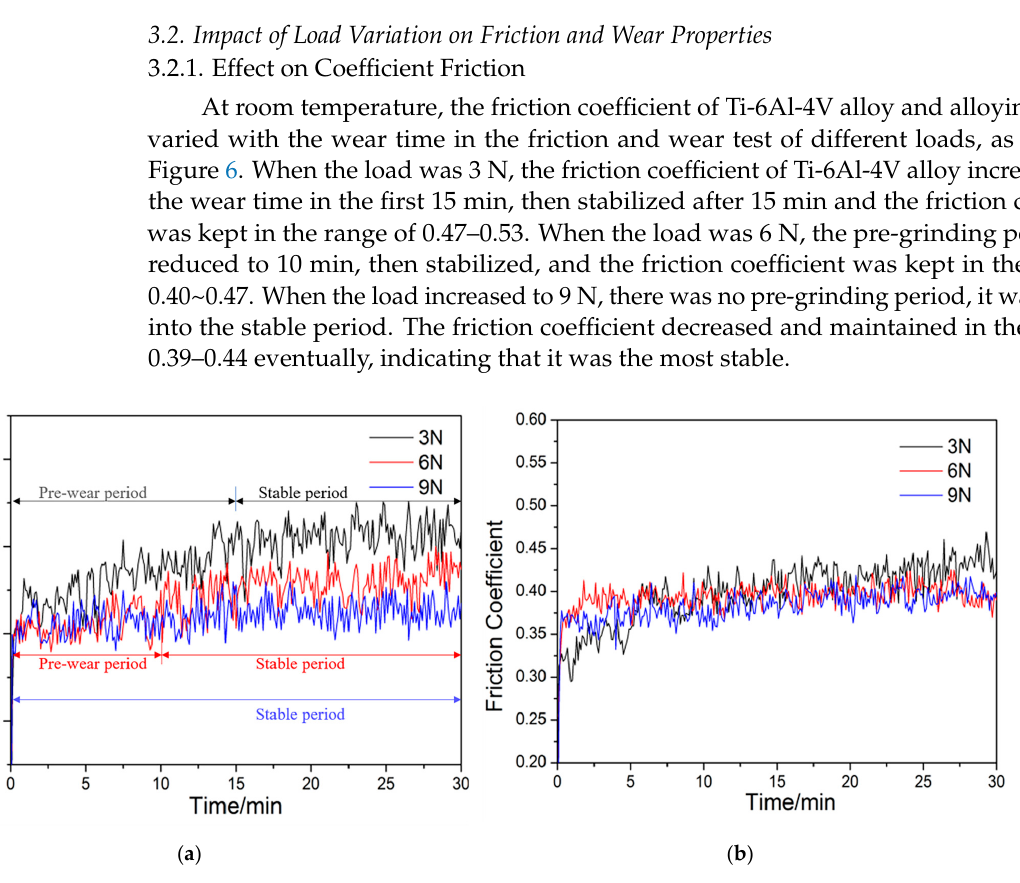
Figure 6. Variation curve of friction coefficient of Ti-6Al-4V alloy and alloying coating under different load: ( a ) Ti-6Al-4V alloy; ( b ) alloying coating.